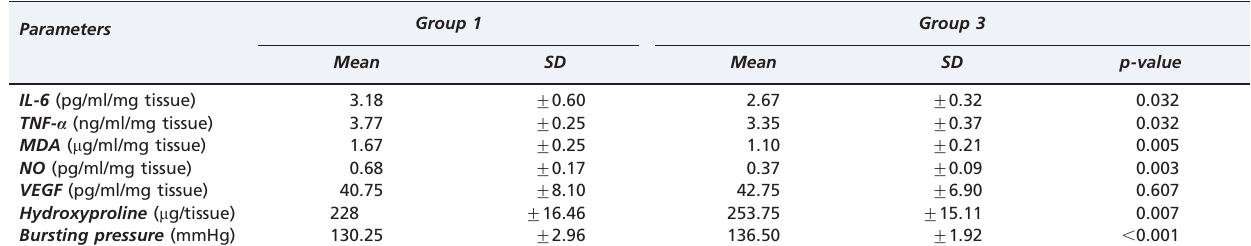
Table 1 - Biochemical assessment and bursting pressures in groups 1 and 3, sacrificed on postoperative day 3.